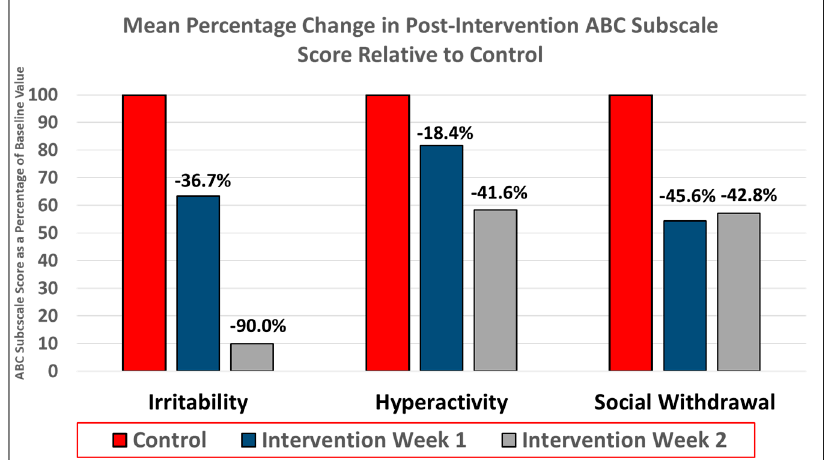
Figure 4. Results of the controlled efficacy stage. Improvement in symptoms of irritability, hyperactivity, and social withdrawal as determined by percentage reduction in ABC subscale scores post-intervention relative to baseline. Irritability, hyperactivity, and social withdrawal were improved at both intervention time points relative to control